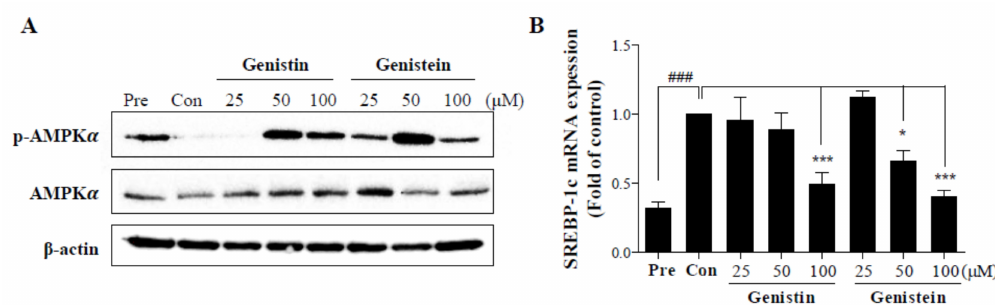
Figure 5. E ff ect of genistin and genistein on protein expression and mRNA levels of AMPK α and SREBP-1c in 3T3-L1 adipocytes. 3T3-L1 cells were completely di ff erentiated in the MDI media in